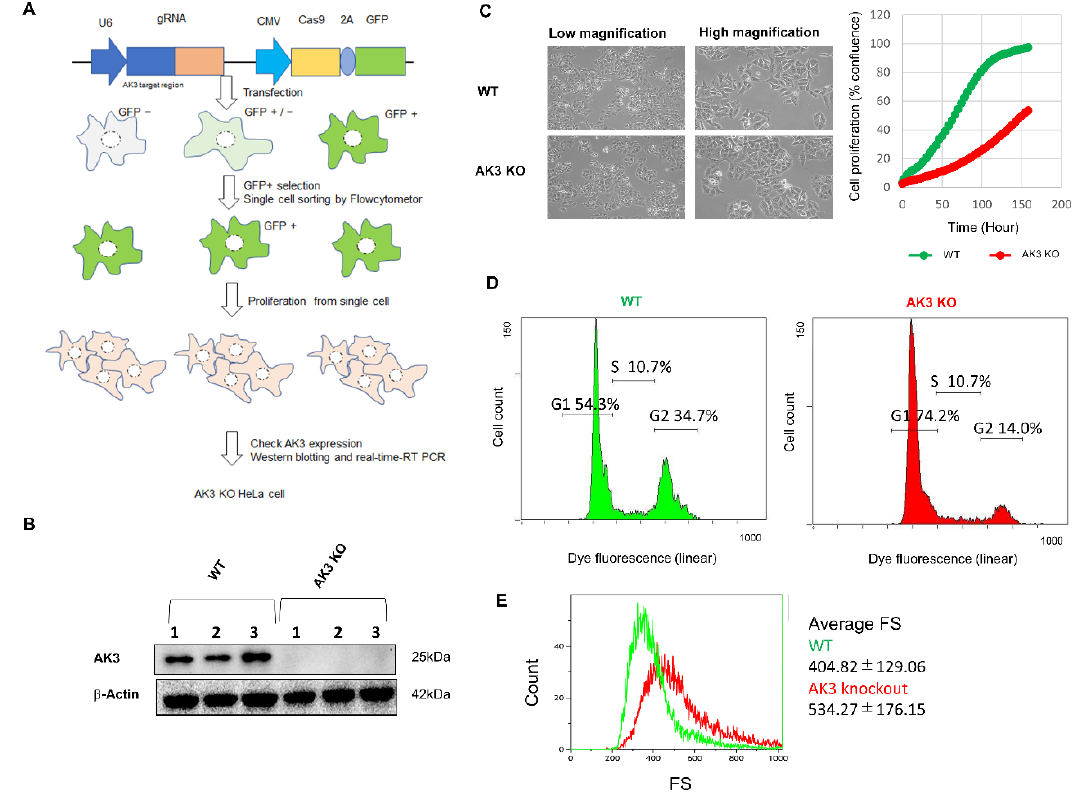
Figure 1. Changes in adenylate kinase 3 knockout (AK3KO) cell. ( A ) Schematic diagram of AK3KO cell production. Plasmid with AK3-targeted genomic RNA (gRNA) exposed to U6 promoter and clustered regularly interspaced short palindromic repeats (CRISPR)-associated protein 9 (Cas9) and green fluorescent protein (GFP) with cytomegalovirus (CMV) promoter was introduced into HeLa cells. Then, GFP co-expressing cells were single-sorted using flow cytometry. Cells grown from a single cell were regarded as AK3KO HeLa cells. Then, each clone was cultured and AK3 protein expression was checking with Western blotting. The clones which showed no protein and mRNA signals were considered as AK3 KO clones. ( B ) Confirmation of AK3KO cell lines from different clones using Western blotting. ( C ) Evaluation of cell morphology (left) and proliferation rate (right) and ( D ) cell cycle and ( E ) size using flow cytometry. FS: forward scatter.